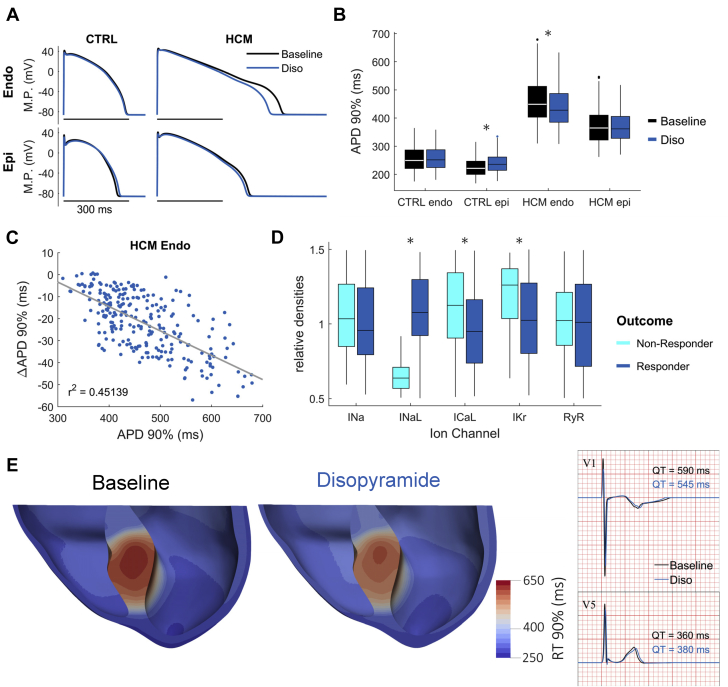
Modeling Results on the Action of Disopyramide on the Dispersion of Repolarization(A) Representative superimposed action potentials at baseline (black traces) and in the presence of disopyramide 5 μmol/l (blue traces) in endocardial (Endo) and epicardial (Epi) models of human ventricular cardiomyocytes at 1 Hz pacing. (B) APD90% at baseline (black) and in the presence of disopyramide 5 μmol/l (blue), for the different cell types. *p < 0.05, paired Student’s t-test. (C) Endocardial APD shortening in HCM endocardial cardiomyocytes under disopyramide 5 μmol/l action as a function of baseline APD90%. (D) Cellular mechanisms underlying endocardial APD shortening in responders (dark blue) versus nonresponders (light blue) to disopyramide. *p < 0.05, unpaired Student’s t-test. (E) RT90% in a ventricular model of obstructive HCM. Disopyramide reduces maximum dispersion of repolarization in the septal hypertrophic region while only slightly prolonging repolarization in nonhypertrophic epicardium, leading to QT shortening in septal compared with modest QT prolongation in lateral precordial electrocardiogram leads (V1 and V5 shown). CTRL = control model; IKr = rapid delayed-rectifier K+ current; RyR = ryanodine receptor; other abbreviations as in Figures 1, 2, 3, and 4.